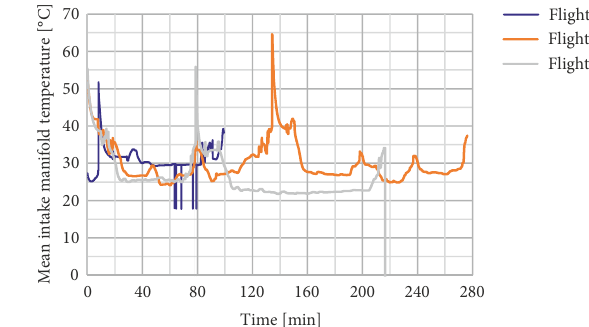
Figure 5. Mean intake manifold temperature for the Liberty XL2 flights